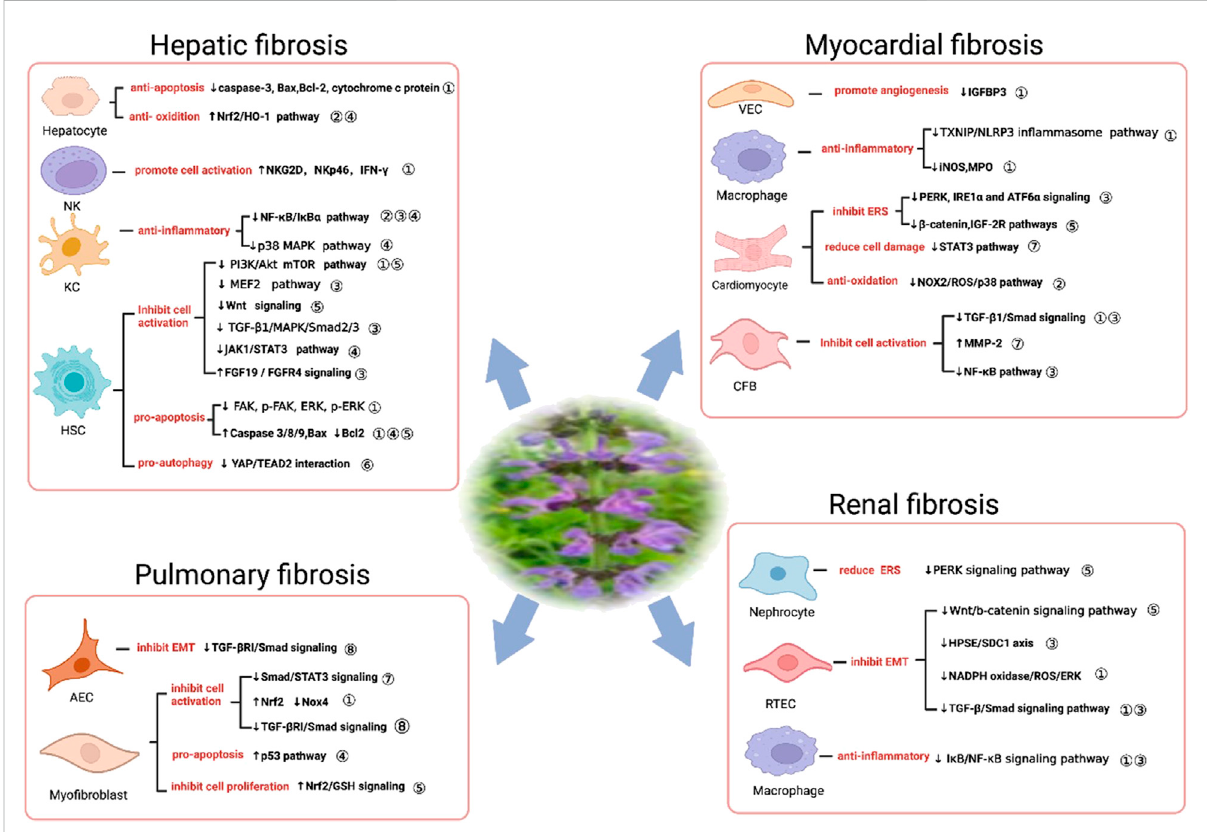
FIGURE 3 Pharmacological mechanismsof SM and its active ingredients in liver, lung, kidney and heart fi brosis. Ingredients in SM, ① Salvia miltiorrhiza ; ② Tanshinol; ③ SalvianolicacidB; ④ Salvianolicacid A; ⑤ Tanshinone IIA; ⑥ DihydrotanshinoneI; ⑦ Cryptotanshinone; ⑧ MagnesiumLithospermate B. Abbreviations, NK, natural killer cells; KC, Kupffer cell; HSC, Hepatic stellate cell; VEC, vascular endothelial cell; CFB, myocardial fi broblast; AEC, alveolar epithelial cell; RTEC, renal tubular epithelial cell; Bax, B-cell lymphoma-2-associated X protein; BCL2, B-cell lymphoma-2; Nrf2, nuclear factor-erythroid 2-related factor 2; HO-1, heme oxygenase-1; NKG2D, natural killer cell group 2D; NF- κ B, nuclear factor kappa-B; I κ B, inhibitor of nuclear factor kappa-B; MAPK, mitogen-activated protein kinase; PI3K, phosphatidylinositol-3-kinase; Akt, protein kinase B; mTOR, molecular target of rapamycin; MEF2, myocyte enhancer factor 2; TGF β 1, transforming growth factor β 1; Smad, drosophila mothers against decapentaplegic protein 2/3; JAK1, Janus kinase one; STAT3, signal transducer and activator of transcription three; FGF19, fi broblast growth factor 19;FGFR4, fi broblastgrowthfactorreceptor4;FAK,focaladhesionkinase;p-FAK,phosphorylatedfocaladhesionkinase;ERK,extracellularregulated protein kinases; p-ERK, phosphorylated extracellular regulated protein kinases; YAP, yes-associated protein; TEAD2, TEA domain family member two; IGFBP3,insulin-like growth factor-binding protein 3; TXNIP, thioredoxin interacting protein; NLRP3, Nucleotide-binding oligomerization domain;leucine-richrepeatandpyrindomain-containingthree;iNOS,inductiblenitricoxidesynthase;MPO,myeloperoxidase;PERK,proteinkinase R-like endoplasmic reticulum kinase;IRE1 α , Inositol requiring enzyme1 α ;ATF6 α , activating transcription factor 6 α ;IGF-2R, insulin-like growth factor 2 receptor; NOX2, nicotinamide adenine dinucleotide phosphate oxidase two; ROS, reactive oxygen species; MMP-2, matrix metalloproteinase-2; EMT, epithelial-mesenchymal transition; TGF- β RI, transforming growth factor β receptor I; GSH, glutathione; ERS, endoplasmic reticulum stress; HPSE, heparinase; SDC1,syndecan-1; NADPH oxidase, reduced nicotinamide adenine dinucleotide phosphate oxidase; ↑ activate; ↓